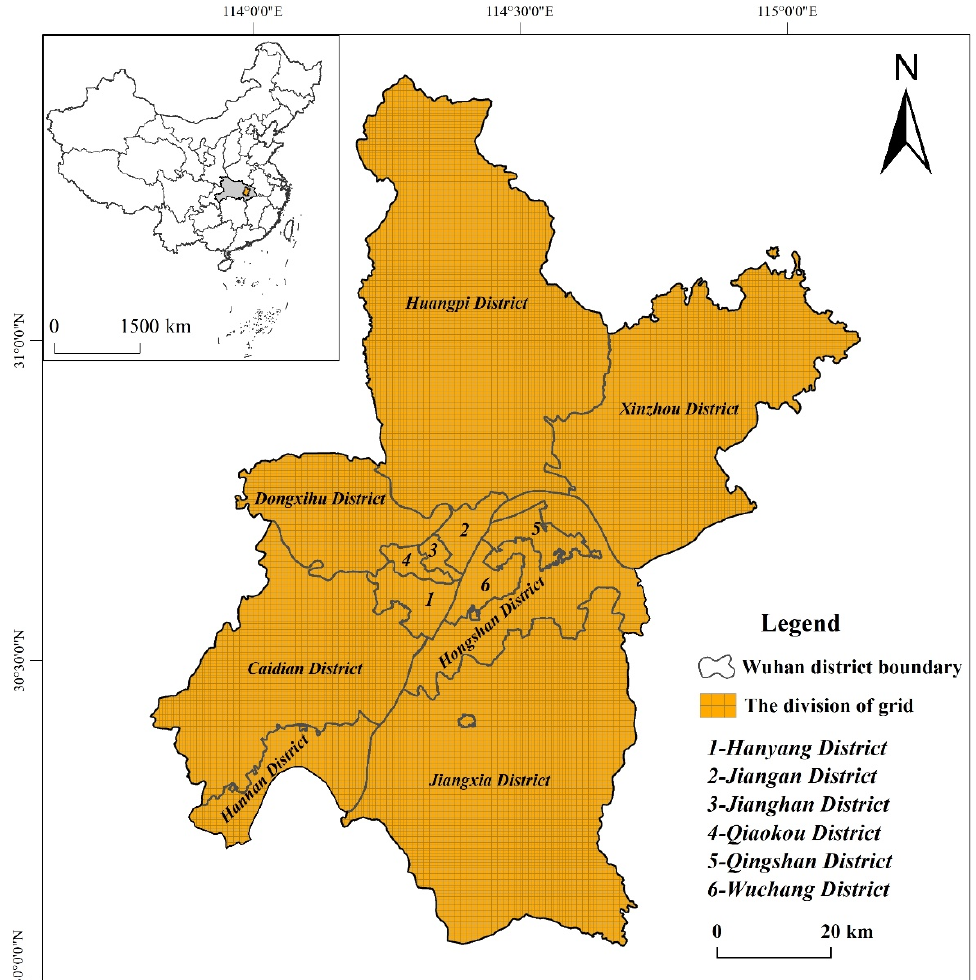
Figure 1. Location of Wuhan in China, its 13 districts, and the grid division with a cell size of 500 m × 500 m.